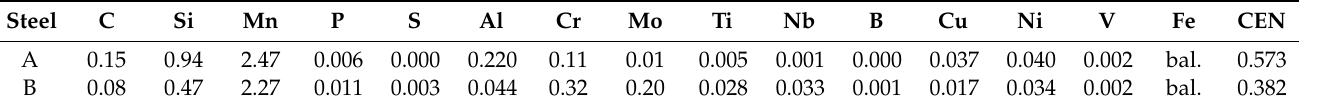
Table 4. Chemical composition (wt%) and carbon equivalent of steels A and